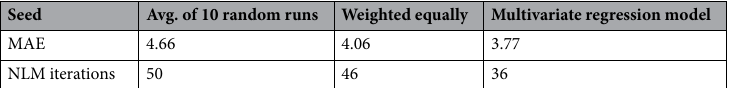
Table 10. MAE achieved and iterations performed by NLM procedure using different seeds.